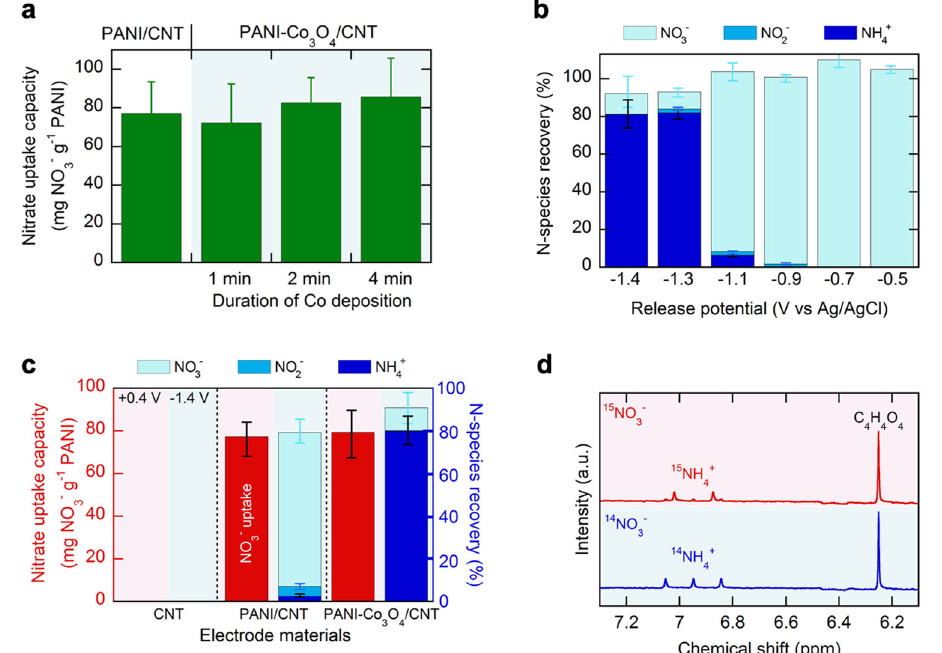
Fig. 6 | Reactive separations using PANI-Co 3 O 4 /CNT composites. a Nitrate uptake capacity using PANI/CNT and PANI-Co 3 O 4 /CNT composites at various Co 3 O 4 loadings. Electrosorption was carried out in 5mM NaNO 3 +5mM NaCl at +0.4V vs Ag/AgCl for 0.5h. Within the experimental range, the existence of Co 3 O 4 did not bring about any decrease in nitrate electrosorption. b Percentage of nitrogen species recovered in the form of nitrate, nitrite, and ammonium after release into 0.1M NaCl for 1h at various electrode potentials. Before release, electrosorption was carried out in 5mM NaNO 3 +5mM NaCl at +0.4V vs Ag/AgCl